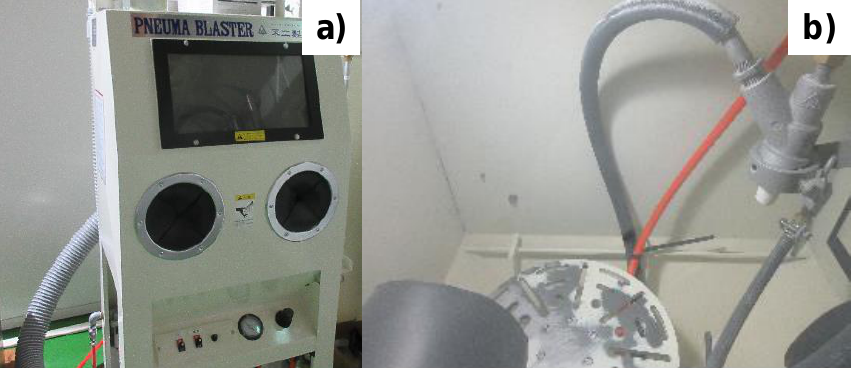
Figure 3. Mechanical blasting equipment. ( a ) Overall image of blasting equipment and ( b ) the shooting stage of substrates in manual operation.